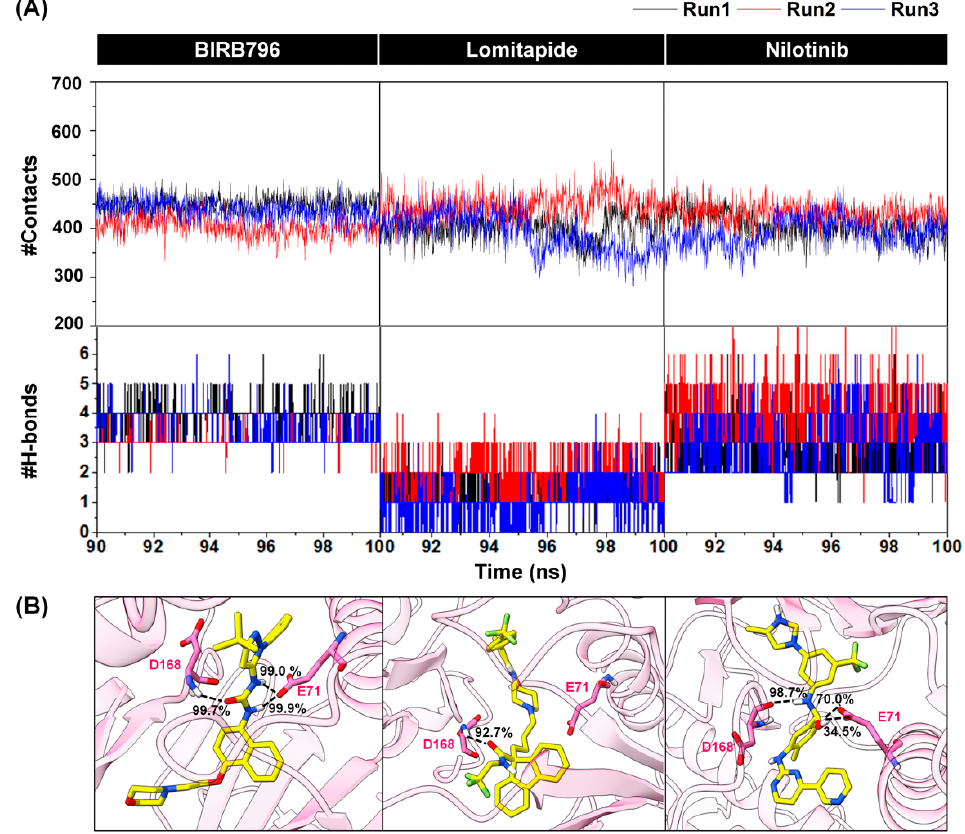
Figure 5. ( A ) Numbers of surrounding atoms counted within the 5.0 Å from the ligand and number of H-bonds within p38 α MAPK-BIRB796 complex and two focused drugs at the last 10 nanoseconds (90–100 ns). The results were shown in three independent runs. ( B ) Percentage of H-bond occurrence during a complex formation of two screened drugs and the BIRB796 using two criteria as follows: (1) the distance between the hydrogen bond donor (HD) and hydrogen acceptor (HA) of ≤ 3.5 Å (2) the angle ≥ 120°.